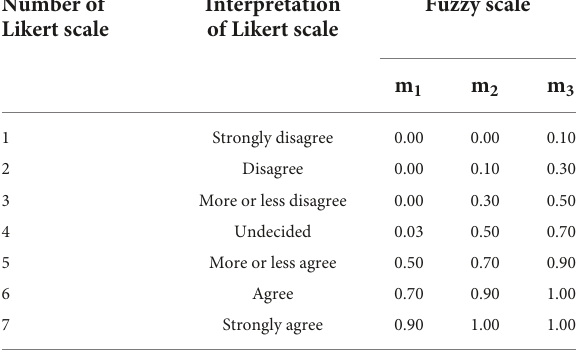
TABLE 2 Seven points of linguistic scale and fuzzy scale. Number of Likert scale